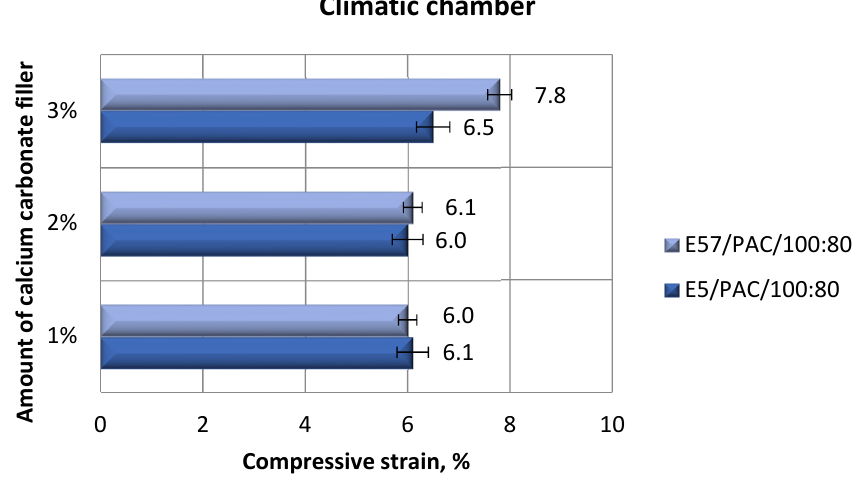
Figure 13. Comparison of the compressive strain between the E5 / PAC / 100:80 and E57 / PAC / 100:80